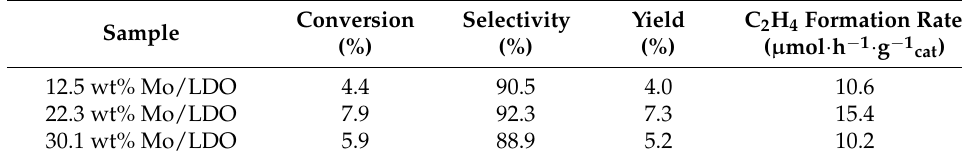
Figure 10. ( a ) Ethane conversion in the stable stage and the initial ethylene formation rate; ( b ) C 2 H 6 conversion and ( c ) C 2 H 4 selectivity as functions of the time on stream over Mo/LDO catalysts. Reaction conditions: T = 873 K, C 2 H 6 /CO 2 /N 2 = 1: 1: 2, the total flow rate = 60 mL min −1 .